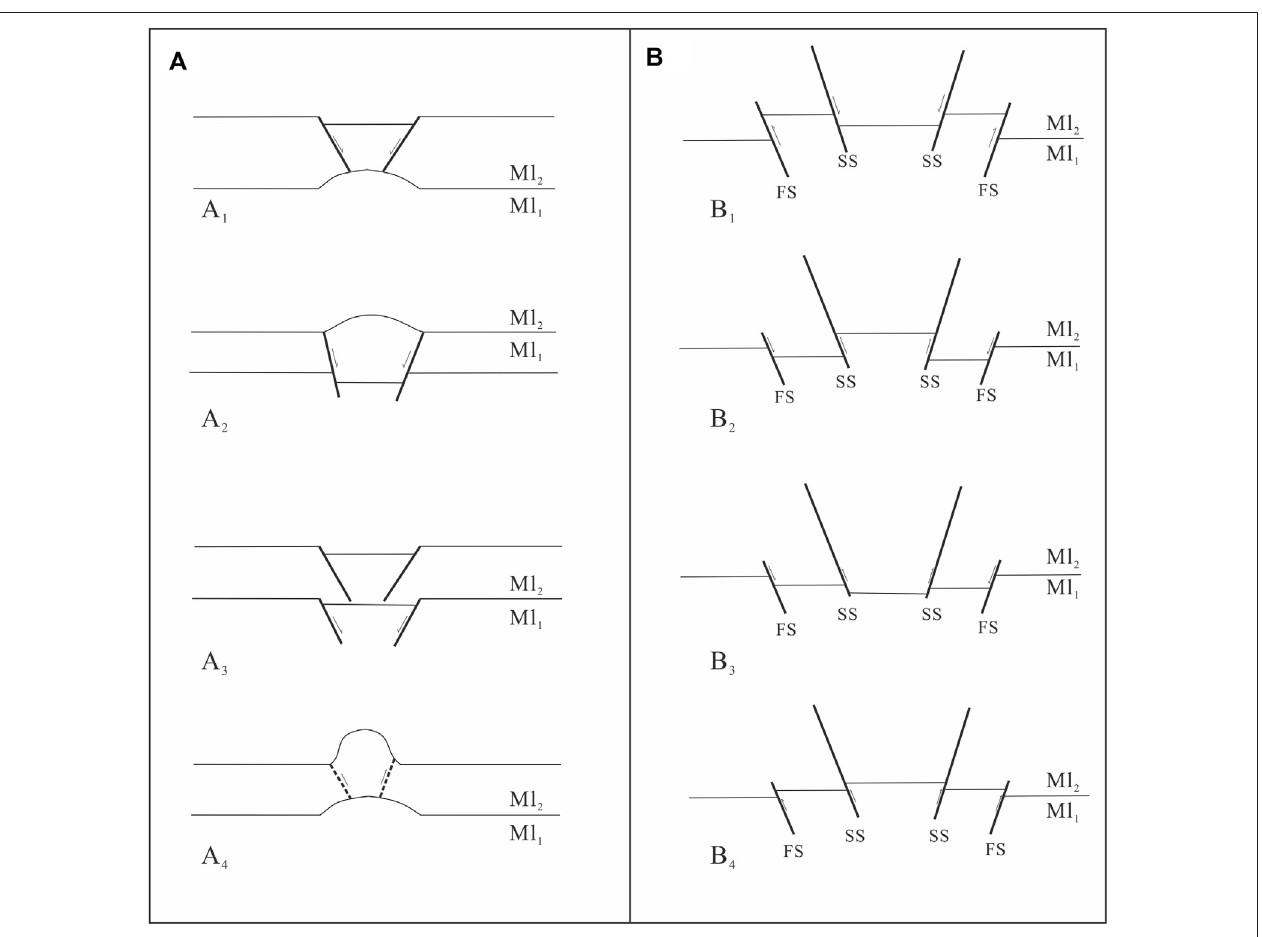
FIGURE 10 | Possible vertical superposition of wrench related structures in various strata. (A) Structures formed in one movement, (B) Structures formed in two movements;